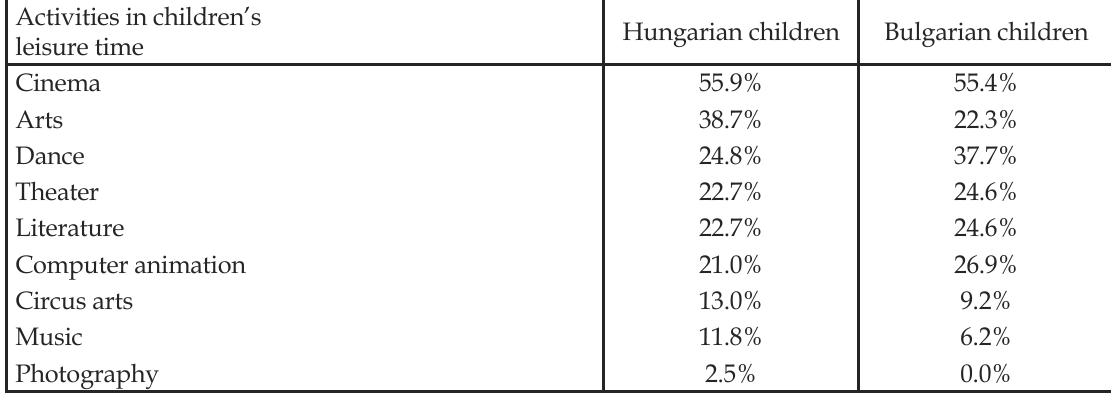
Table 1. Activities in children’s leisure time in Hungary and